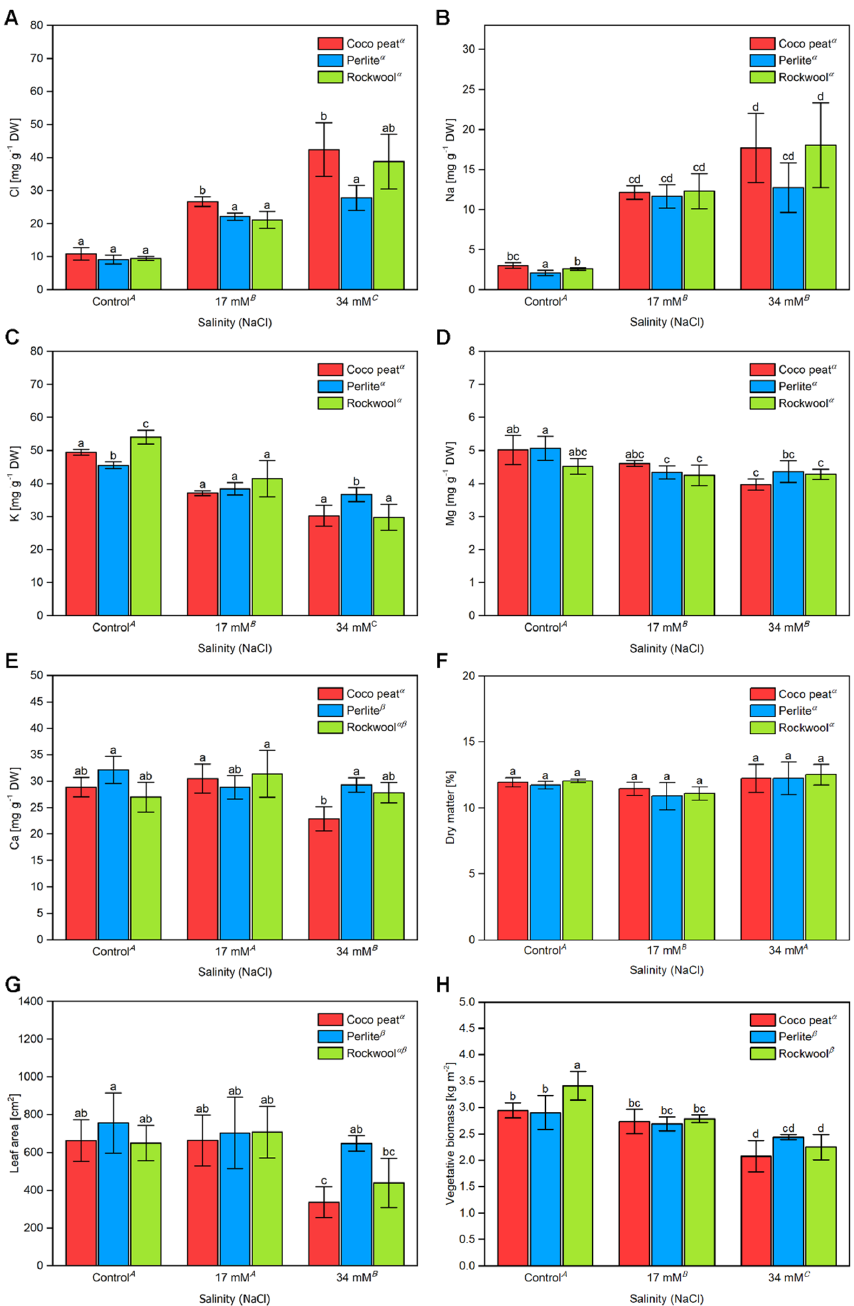
Figure 6. Ion composition, dry matter content, leaf area, and vegetative biomass of tomato plants with increasing salinity. The chloride ( A ), sodium ( B ), potassium ( C ), magnesium ( D ) and calcium (E) content of young tomato leaves grown in different substrates with increasing salinity were sam- pled on 19 October 2017. From the same sample the dry matter ( F ) and leaf area ( G ) was assessed. The vegetative biomass ( H ) was assessed at the end of the experiment. The error bars represent the SD. Statistical comparison of mean values between substrates was calculated for each salinity level separately. Upper-case letters compare the salinity treatments; Greek letters compare different sub- strates, lower-case letters within the graph compare single mean values, within each salinity level separately. The raw data are available in Supplementary File S1.